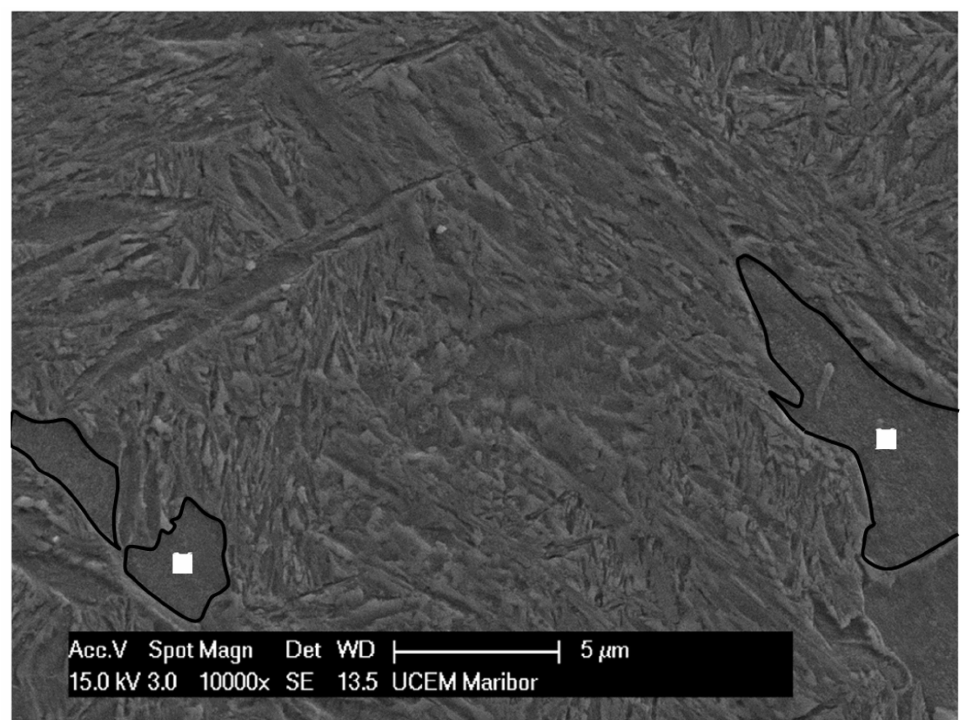
Figure 3. FESEM image of fine bainitic microstructure of the experimental KAB steel.